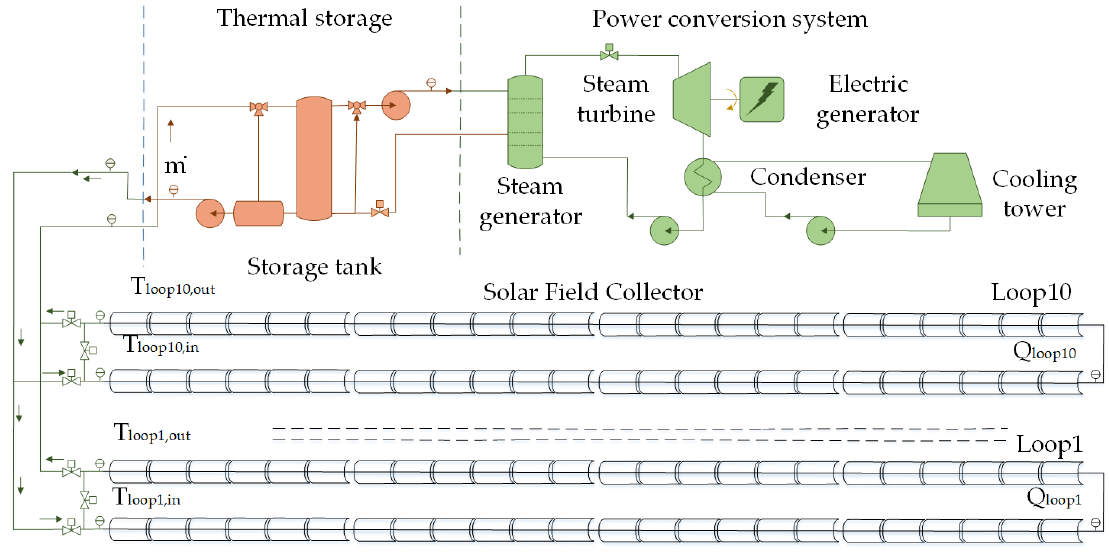
Figure 1. Solar thermal power generation plant.